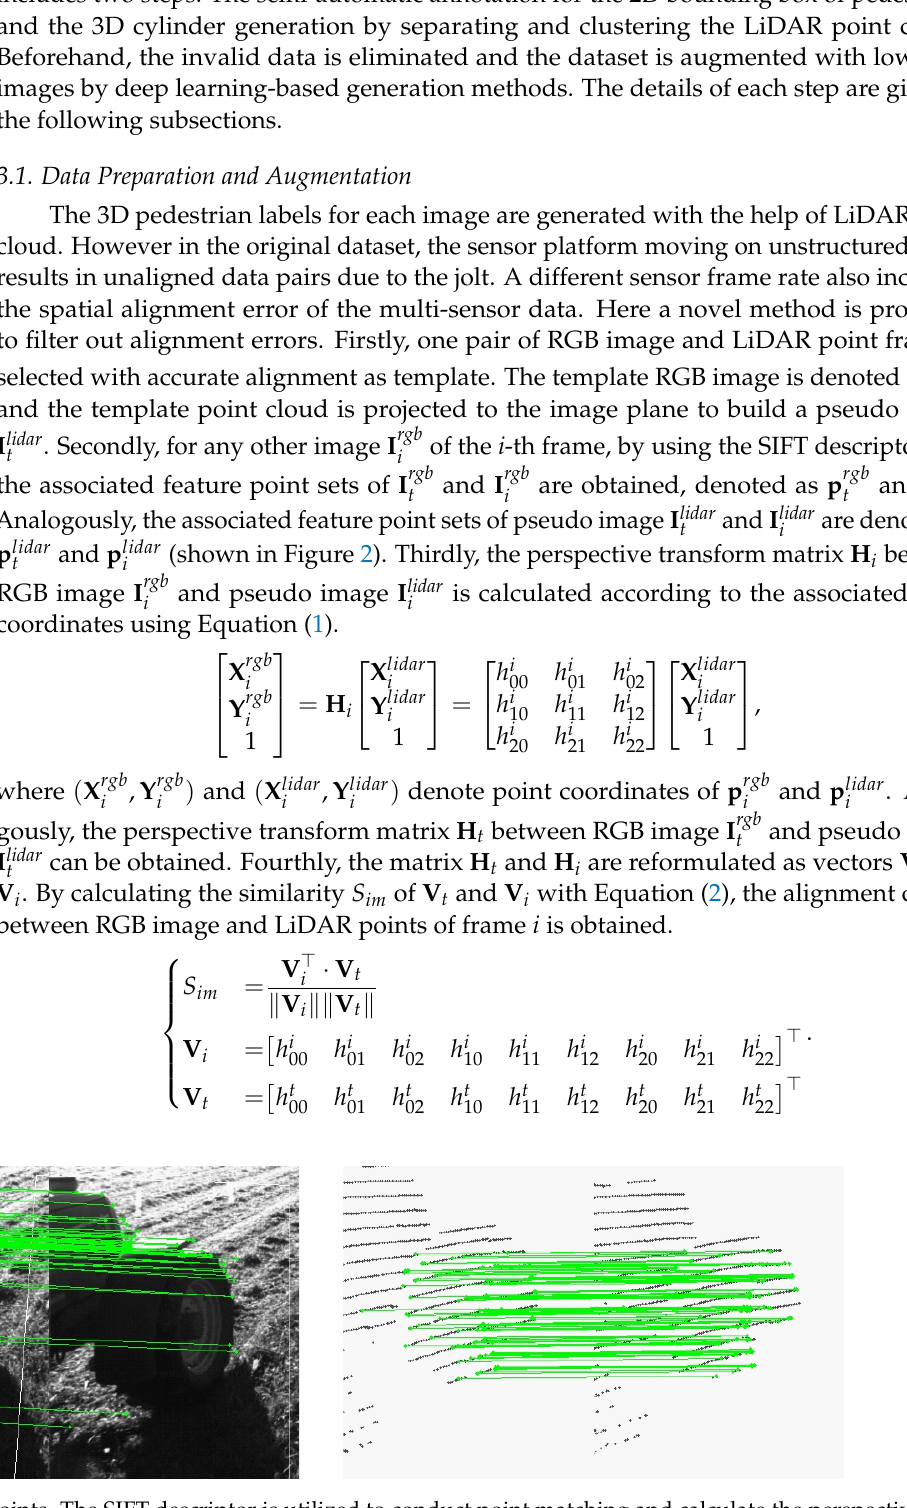
Figure 2. Matched feature points. The SIFT descriptor is utilized to conduct point matching and calculate the perspective transform matrix between the current frame and the